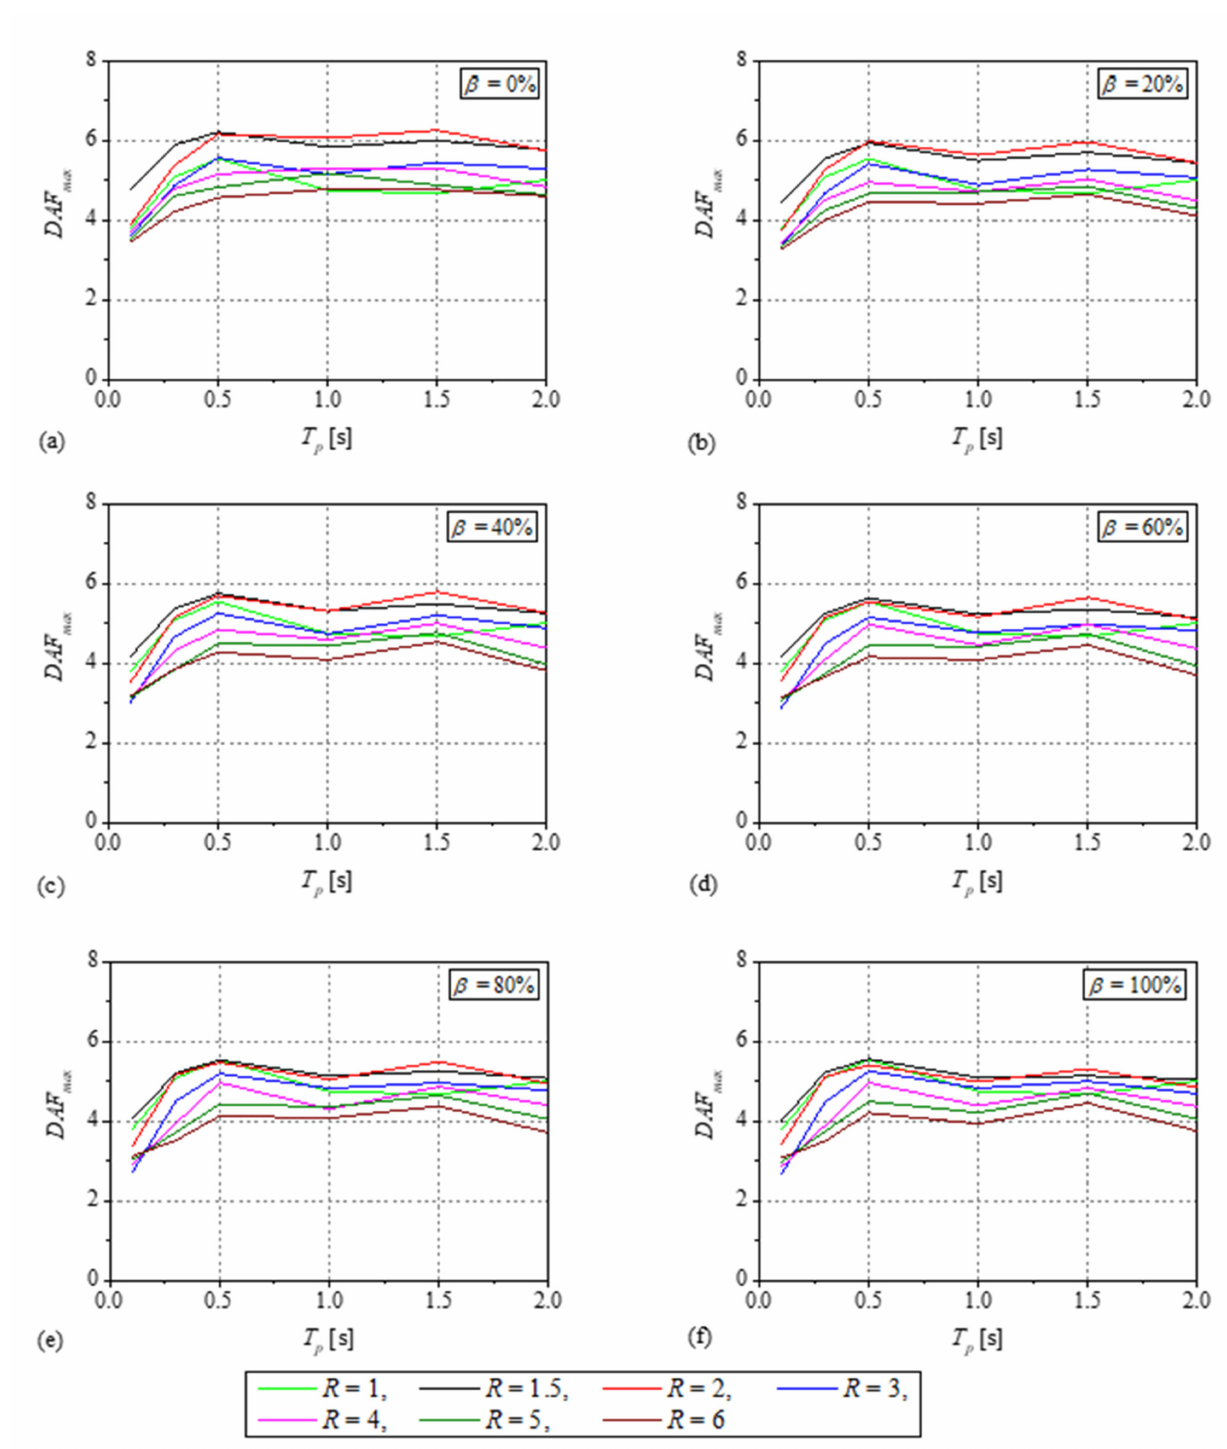
Figure 5. Maximum dynamic amplification factor DAF max for a SC system with post-yield stiffness ratio α = 5%; viscous damping ratio ξ p = 5%; and a secondary structure with viscous damping ratio ξ s = 5%: ( a ) β = 0%; ( b ) β = 20%; ( c ) β = 40%; ( d ) β = 60%; ( e ) β = 80%; and ( f ) β =